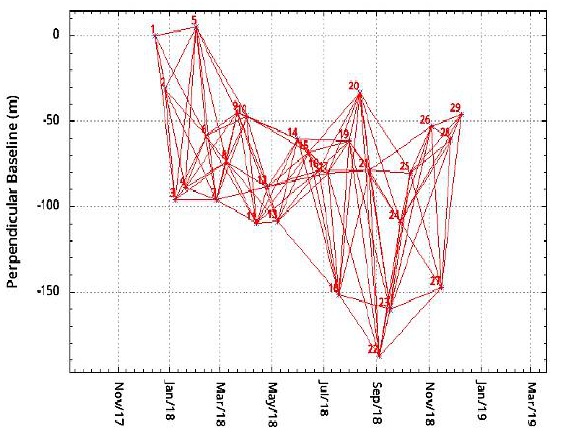
Figure 3. Spatial-temporal baselines of interferograms